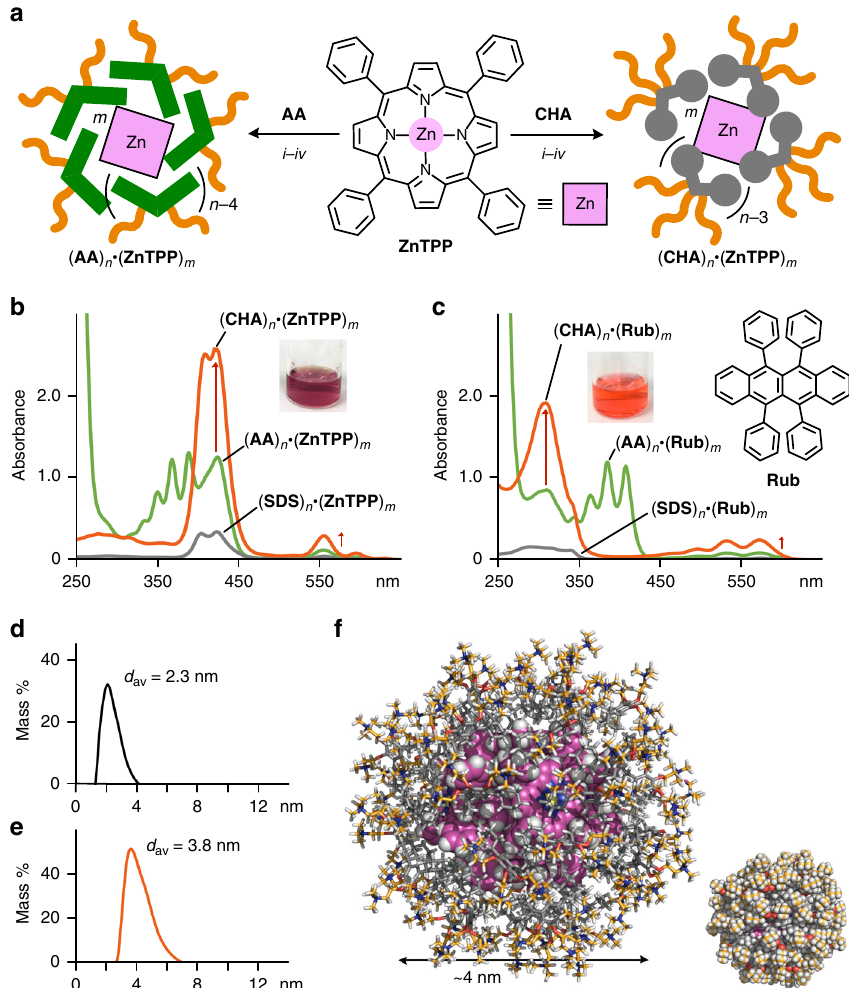
Fig. 3 Enhanced uptake of bulky metal-complex and organic dyes by the cycloalkane-based micelle. a Schematic representation of the uptake of ZnTPP dyes by ( CHA ) n or ( AA ) n through ( i ) grinding (6 min), ( ii ) water addition (2.0 ml), ( iii ) centrifugation (16,000 × g , 10 min), and ( iv ) fi ltration (200 nm pore size). UV – visible spectra and photographs (H 2 O, room temperature, 1.0 mM based on the amphiphiles) of ( CHA ) n , ( AA ) n , and ( SDS ) n uptaking b ZnTPP and c Rub dyes. DLS charts (H 2 O, room temperature) of d ( CHA ) n and e ( CHA ) n • ( ZnTPP ) m (170 and 1.0 mM based on CHA , respectively). f Optimized structure of ( CHA ) 45 • ( ZnTPP ) 9 (white: hydrogen; gray, orange, and purple: carbon; red: oxygen; blue: nitrogen; yellow: